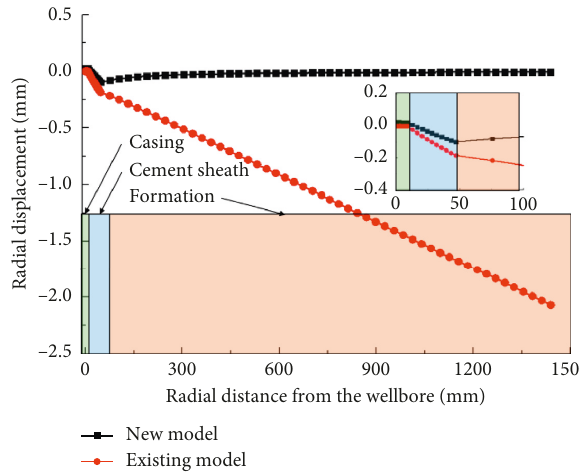
Figure 15: Radial displacements of the wellbore assembly along the 0 °